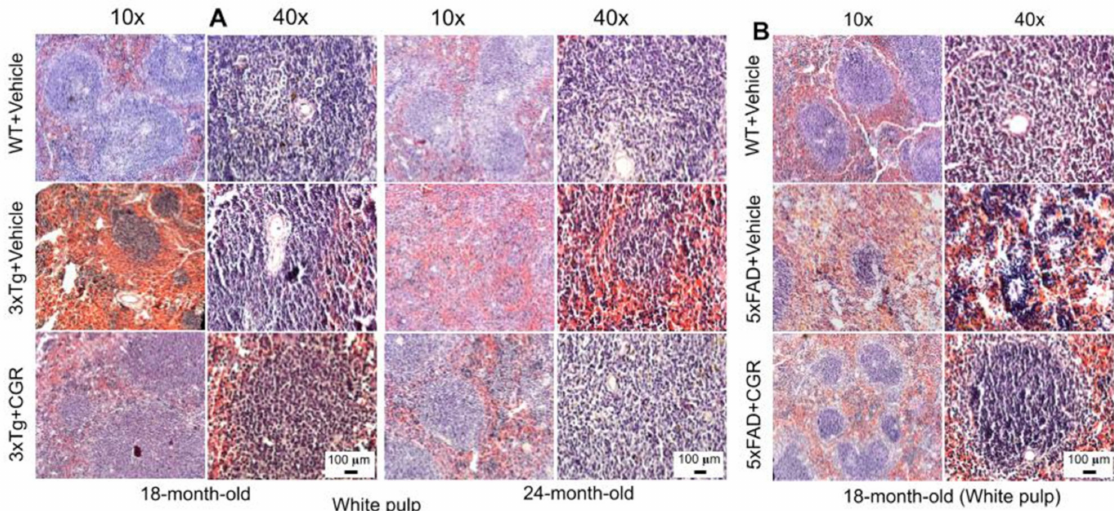
Figure 3. Splenic white-pulp cytoarchitecture was improved by CGR treatment in both 3xTg and 5xFAD mice. Wild-type, and 3xTg, 5xFAD mice treated with CGR (100 mg/kg) for 2 months and the mice were perfused with PBS and fixed with 4% paraformaldehyde and the liver was dissected out, embedded with paraffin and 5 µ m thick sections were cut and stained with hematoxylin and eosin (H&E) and the images were taken by compound light microscope using either 10- or 40 × objectives (total magnification = 100 × or 400 × ). ( A ) Representative images of white pulp (splenic nodules, arrows) of WT+Vehicle, 3xTg+Vehicle and 3xTg+CGR mice from 18-month-old and 24-month-old mice. ( B ) Representative images of splenic white pulp from 18-month-old WT+Vehicle, 5xFAD+Vehicle and 5xFAD+CGR-treated mice. Note that 5xFAD+Vehicle treated mice showed a degeneration of white pulp and CGR treatment prevented these changes. A significant degeneration of white-pulp of spleen was observed in both 3xTg+Vehicle and 5xFAD+Vehicle-treated mice and treatment with CGR ameliorated these changes. Scale bar = 100 µ m and is applicable to all other